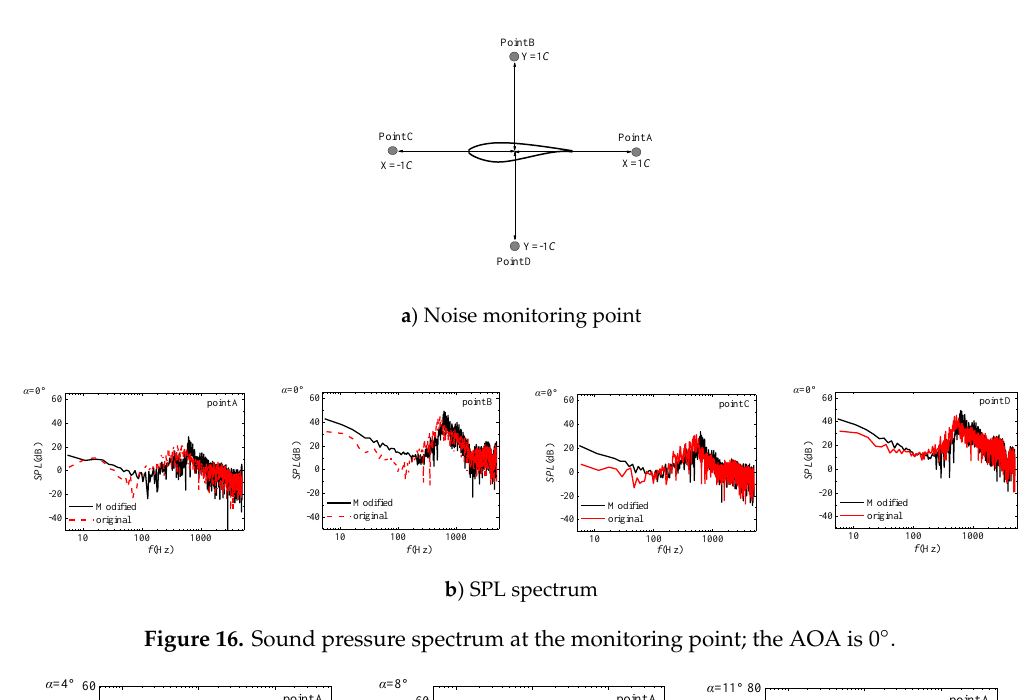
Figure 15. Isosurface of Q (a, b) and vorticity cloud diagram (c, d) at the symmetric plane. ( a ) and (c) are original; ( b ) and (d) are modified.